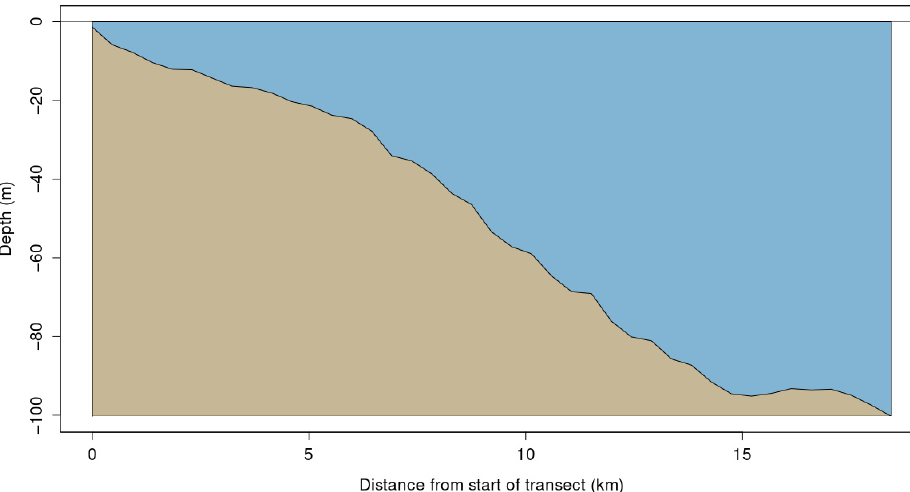
Figure 2. Bathymetric profile of the transect T0.